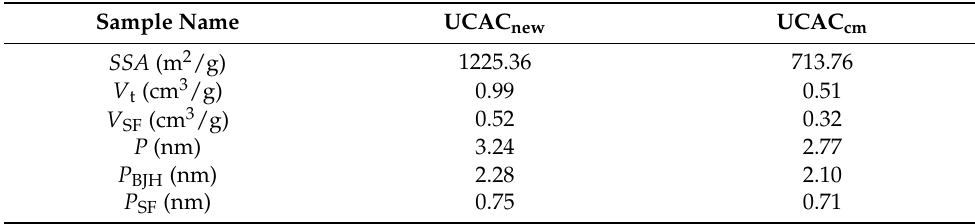
Figure 8. The correlation curve of the pore structure: ( a ) isothermal adsorption curve; ( b ) BJH pore size distribution curve; ( c ) BJH pore area distribution; ( d ) micropore distribution. The observed SSA , total pore volume ( V t ), total micropore volume ( V SF ), average pore size ( P ), average mesoporous pore size ( P BJH ), and average micropore pore size ( P SF ) of both UCAC new and UCAC cm are given in Table 3. Table 3. Pore structural parameters of two types of